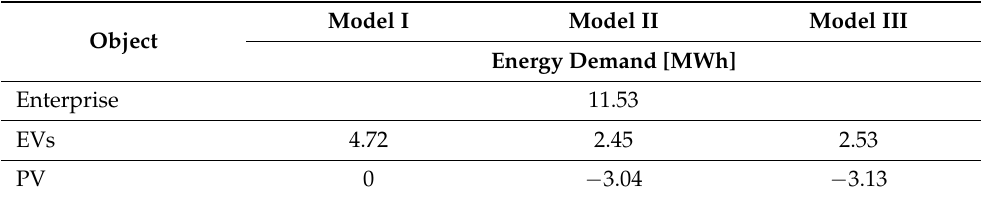
Table 6. Summary of energy consumption for all models